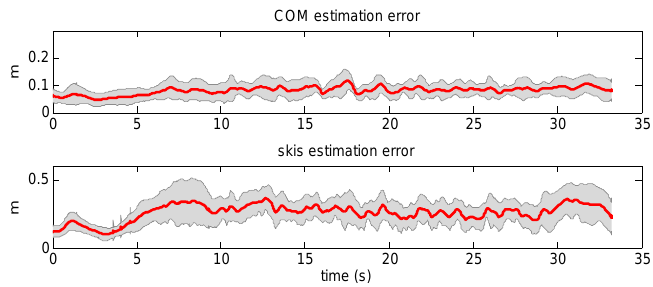
Figure 9. Mean error between estimated and true values of COM position and the position of skis using the inverted pendulum model for all 18 ski runs. The shadowed region denotes the standard deviation of the mean